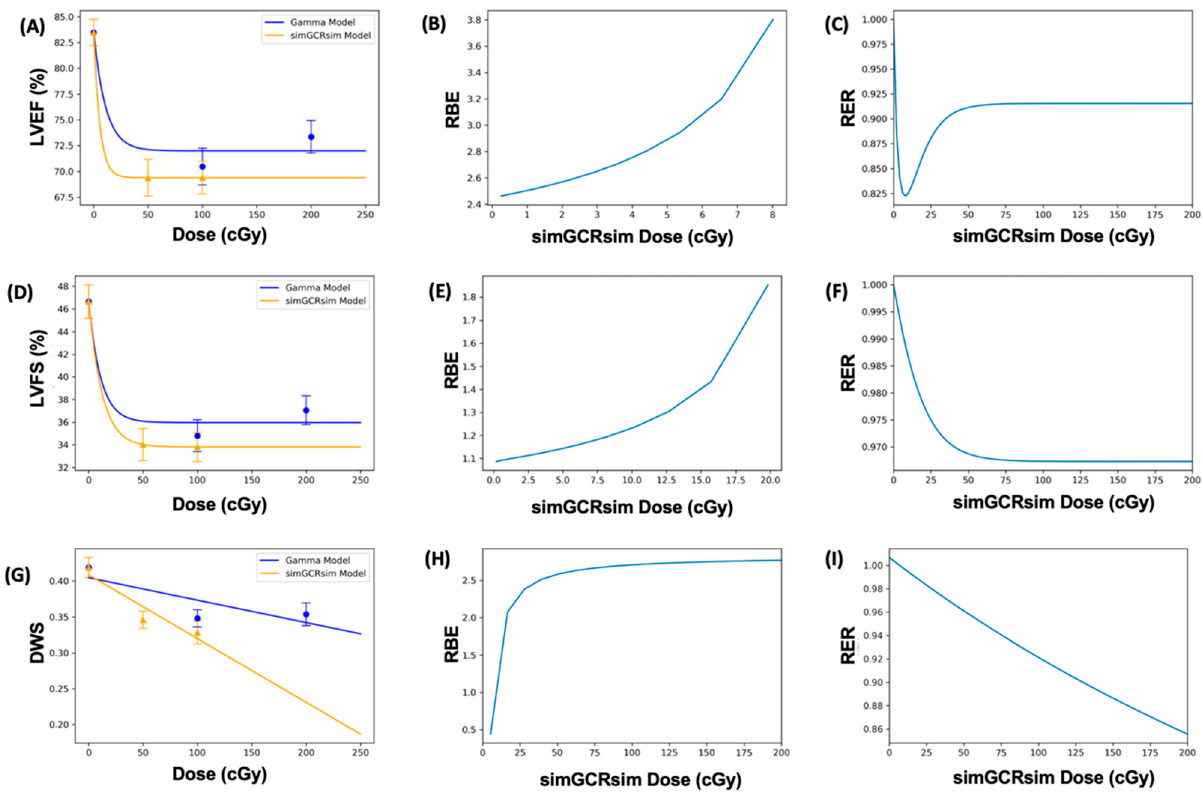
Figure 7. Modeling and comparative effect measures of C57Bl/6J mice 365 days after exposure to gamma and simGCRsim irradiation. Comparison of ( A ) LVEF, ( D ) LVFS, and ( G ) DWS mean dose-response data (SEM error bars) superimposed on BMD dose-response models for gamma (orange triangles) and simGCRsim (blue circles) irradiation. To the right are the corresponding RBE calculations within the viable ranges ( B , E , H ), and the corresponding RER calculation ( C , F , I ) for LVEF, LVFS, and DWS, respectively.